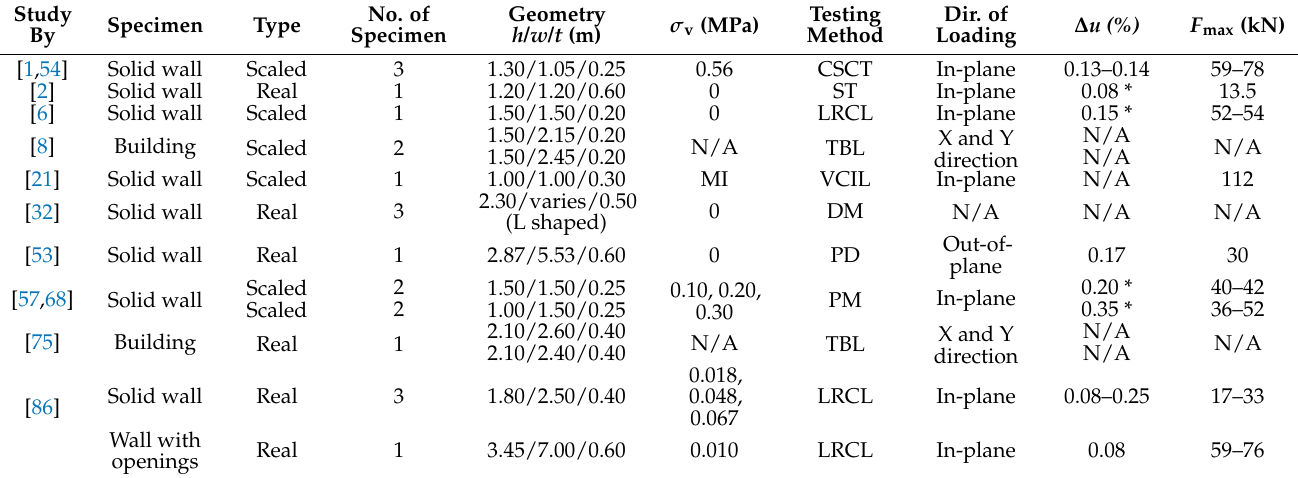
Table 8. Specimen geometry, loading methods, and maximum load attained by country and study observed. Study By